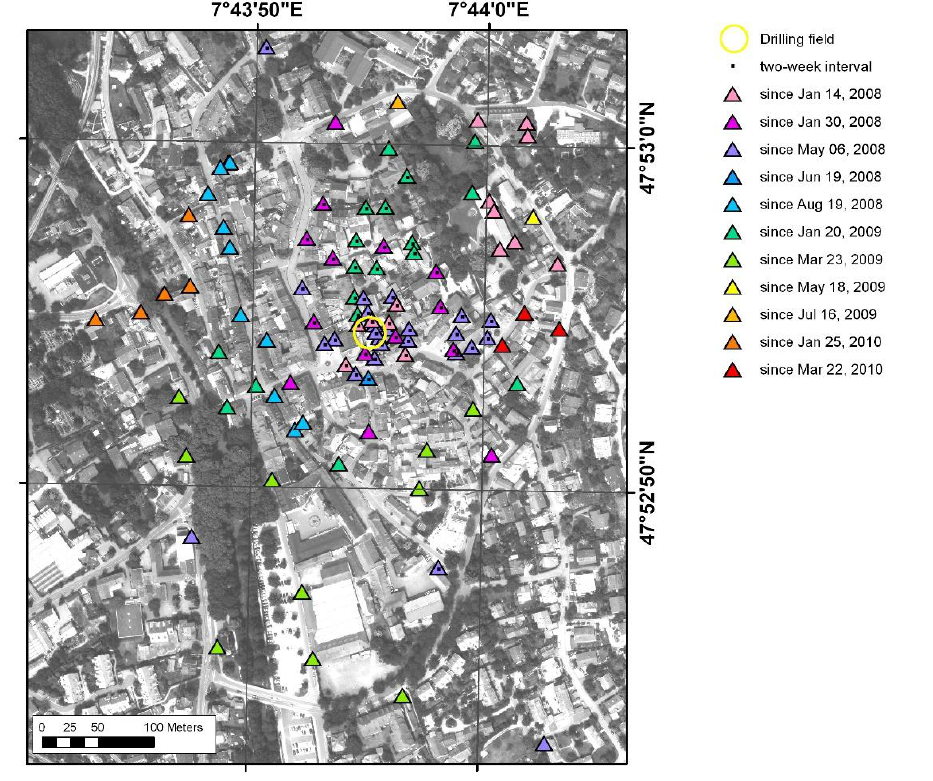
(TSX) satellite for a single location, and with the same viewing geometry, is 11 days, and the spatial coverage of images recorded in Stripmap mode (resolution of approximately 3 m), which are used in this study, is approximately 30 km in range and 50 km in azimuth. Figure 3. Location of the leveling survey points (provided by Landratsamt Breisgau Hochschwarzwald, office Müllheim) plotted on an orthophoto of Staufen (acquired by the State Survey Office of Baden-Württemberg). The expansion of the network is color-coded. The points at which measurements are repeated every two weeks are marked with a black dot in their centre. The drilling field is indicated by a yellow